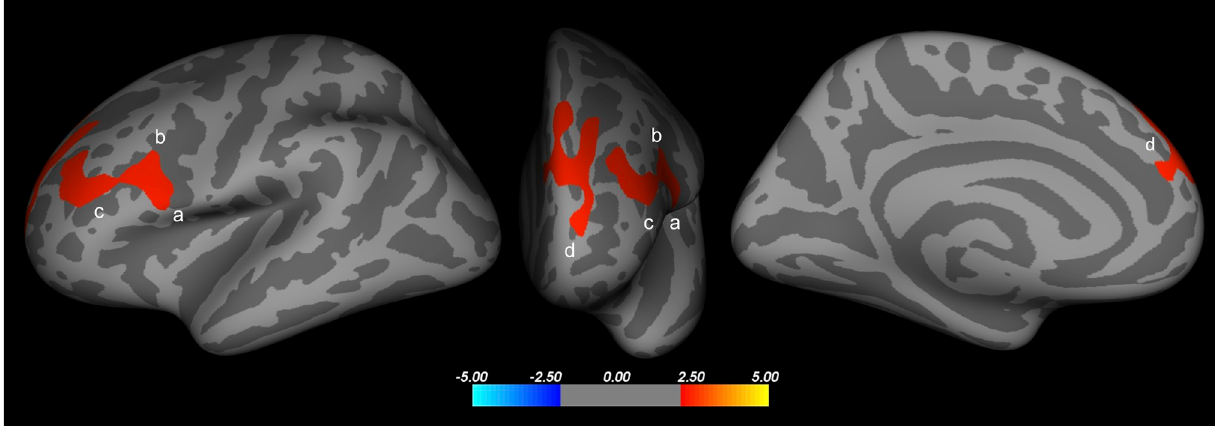
Fig 1. Clusters of significantly greater cortical thickness the left hemisphere in HIV-infected patients with (vs. HIV-infected without) working memory impairment. Left pars opercularis of the inferior frontal gyrus (a), caudal (b) and rostral (c) portions of the middle frontal gyrus, and left superior frontal gyrus